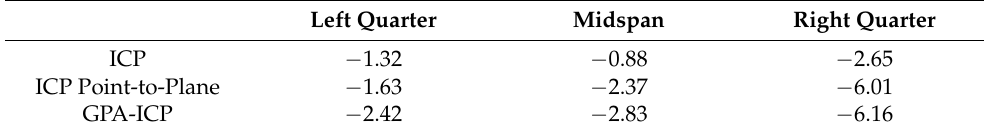
Table 7. Second load test averaged